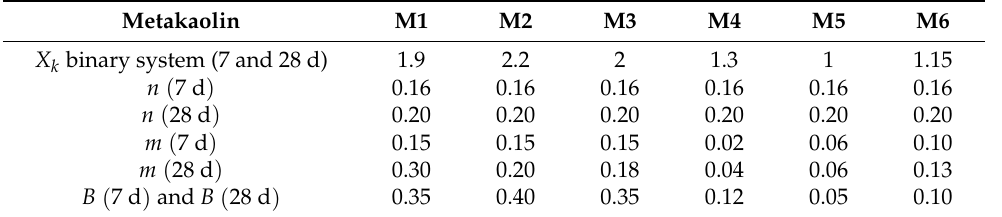
Figure 5. Left: Compressive strengths as a function of the water-to-binder ratio (W/B) with different types of metakaolin at 7 ( a ) and 28 days ( c ). Right: Same compressive strengths represented as a function of the equivalent binder-to-water ratio (CEM + MK) at 7 ( b ) and 28 days ( d ). The shifts used for the right graphics are given in the first row of Table 10. Table 10. Reactivity factors used to obtain both the equivalent binder concentration (Equation (2)) and the master curves in Figure 5. The reactivity factor n is the same as that for the GCC/cement binary system, and the two factors m and k are obtained from the calculated porosity (Equations (4) and (5)) and from the master curves in Figures 3 and